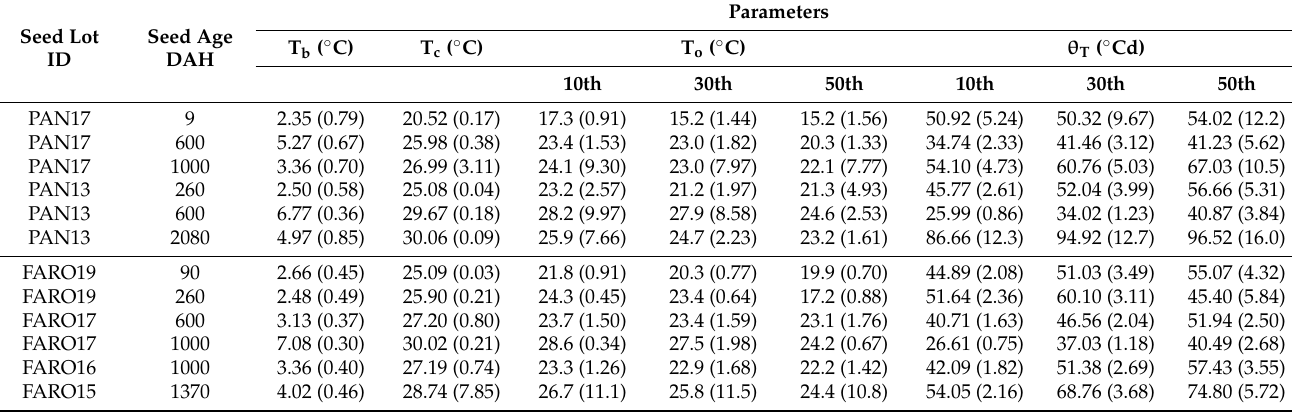
Table 1. Threshold temperatures and thermal requirements for S. hicesiae PAN and FARO seed sources, with standard errors in parentheses, at different seed ages (days after harvest = DAH). No differences across percentiles were found for base temperature and ceiling temperature. T b , base temperature; T c , ceiling temperature; T o , optimal temperature; θ T , thermal time to germination for the corresponding